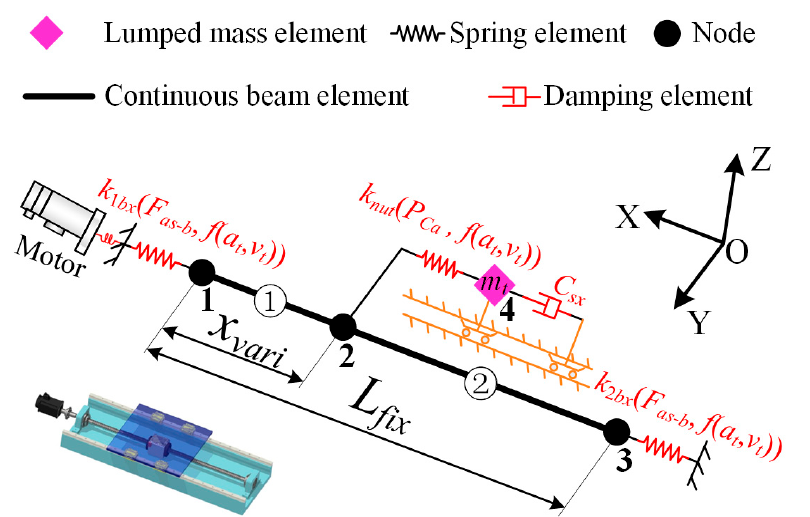
Figure 2. Equivalent dynamic model of a ball screw feed system.